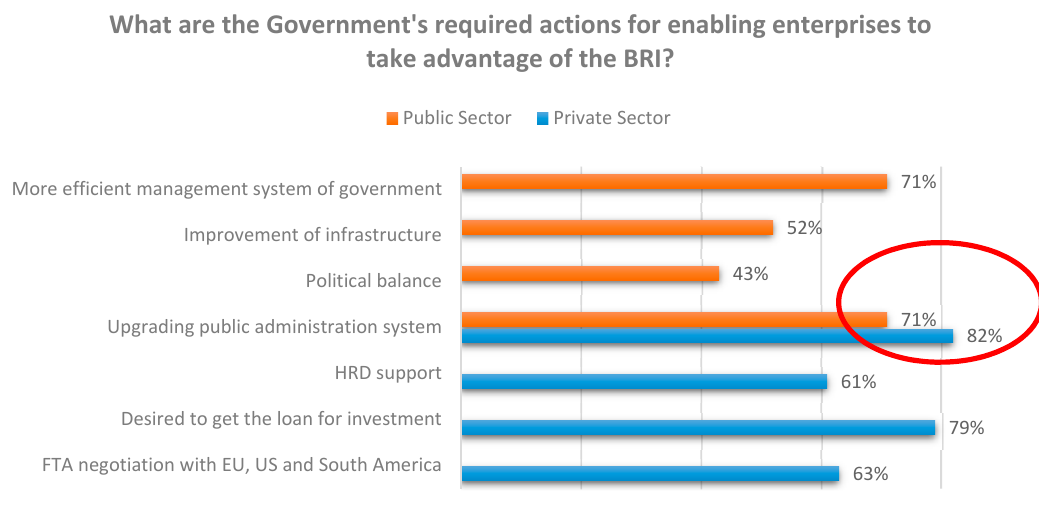
Figure 8. Improving the existing public administration system becomes crucial (Source: Authors’ analysis).